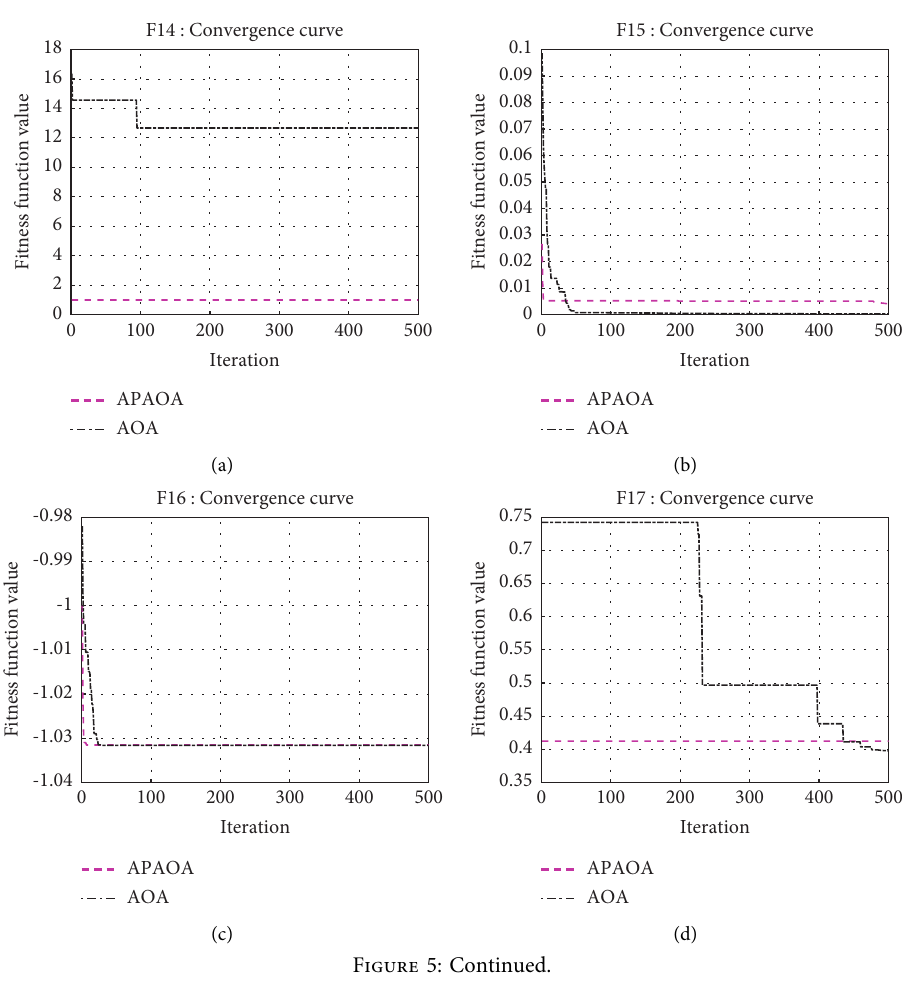
F14 : Convergence curve F15 : Convergence curve